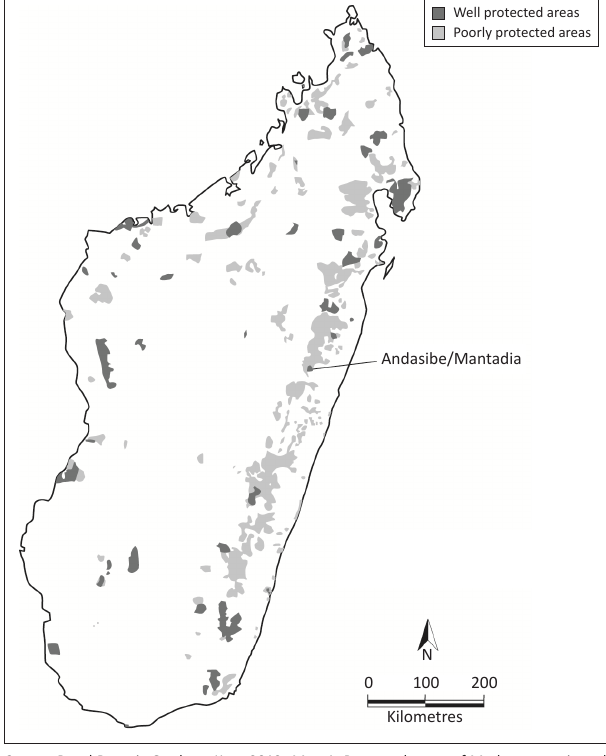
FIGURE 2: Map of the protected areas (national parks, nature reserves and special reserves) of Madagascar. Note that a significant portion of the protected area network is inadequately protected.